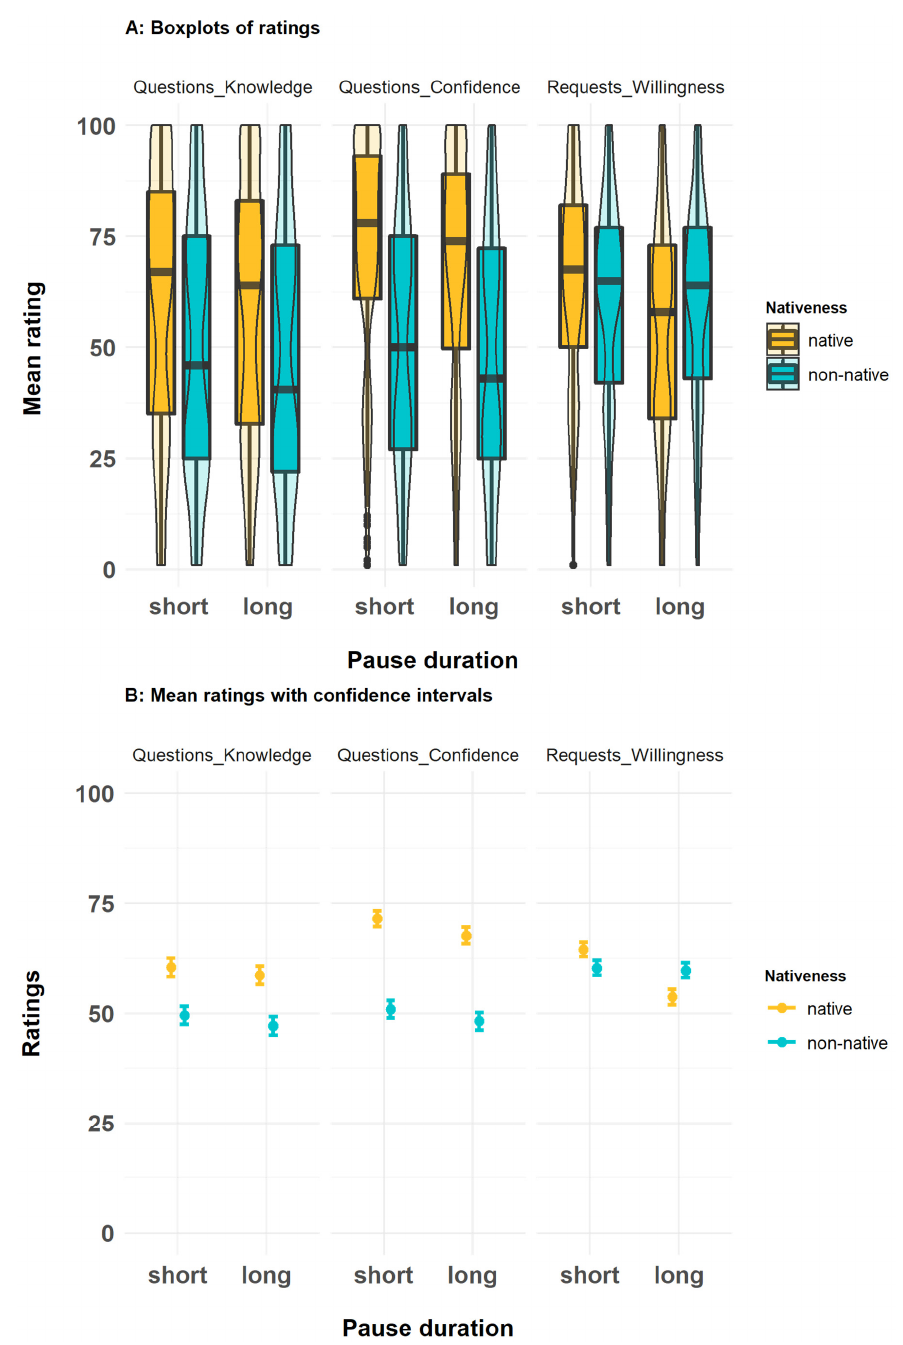
Figure 1. Ratings of the perceived knowledge and confidence of speakers answering knowledge questions, and of the perceived willingness of speakers to comply with requests. Answers were given either by native or non-native speakers and were preceded by either a short (200 ms) or long (1200 ms) pause. Ratings range from 0 (not knowledgeable/confident/willing at all) to 100 (very knowledgeable/confident/willing). ( A ): Boxes depict medians and quartiles, whiskers depict minimum and maximum values, and black dots depict outliers. Violin shapes around the boxes depict the distribution of the ratings. The width of the violin shapes at a given y coordinate corresponds to the number of ratings in this region. Note that, when evaluating the speakers’ knowledge, confidence and willingness, participants used the full range of the rating scale. ( B ): Mean and 95% confidence intervals of participants’ responses. Non-overlapping confidence intervals indicate significant differences between the groups. Table 1. Results of the linear mixed model exploring the effects of pause duration and nativeness on perceived knowledge. The table reports estimated model coefficients (Estimate), standard errors (SE) and p -values ( p ). Because of the non-significant interaction effect in the full model, to determine the effects of pause duration and nativeness alone, we also report the results of a reduced model excluding this interaction effect.